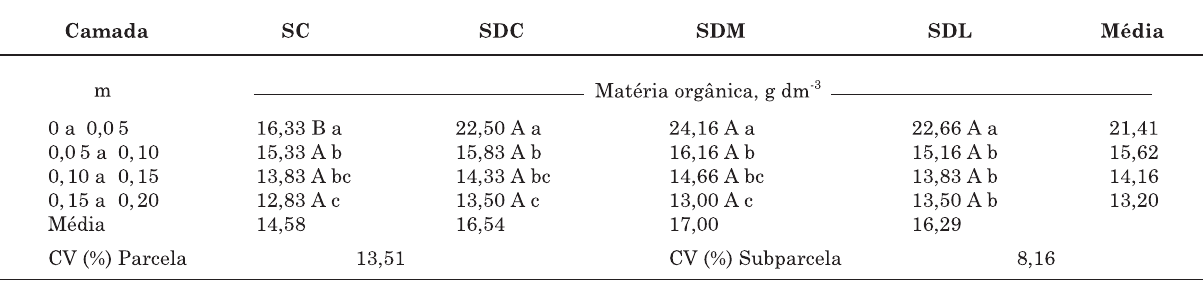
SC: semeadura convencional; SDC: semeadura direta crotalária; SDM: semeadura direta milheto; SDL: semeadura direta lablabe. Médias seguidas da mesma letra não diferem estatisticamente pelo teste de Tukey a 5%. Letras maiúsculas comparam as médias na linha, e minúsculas, na